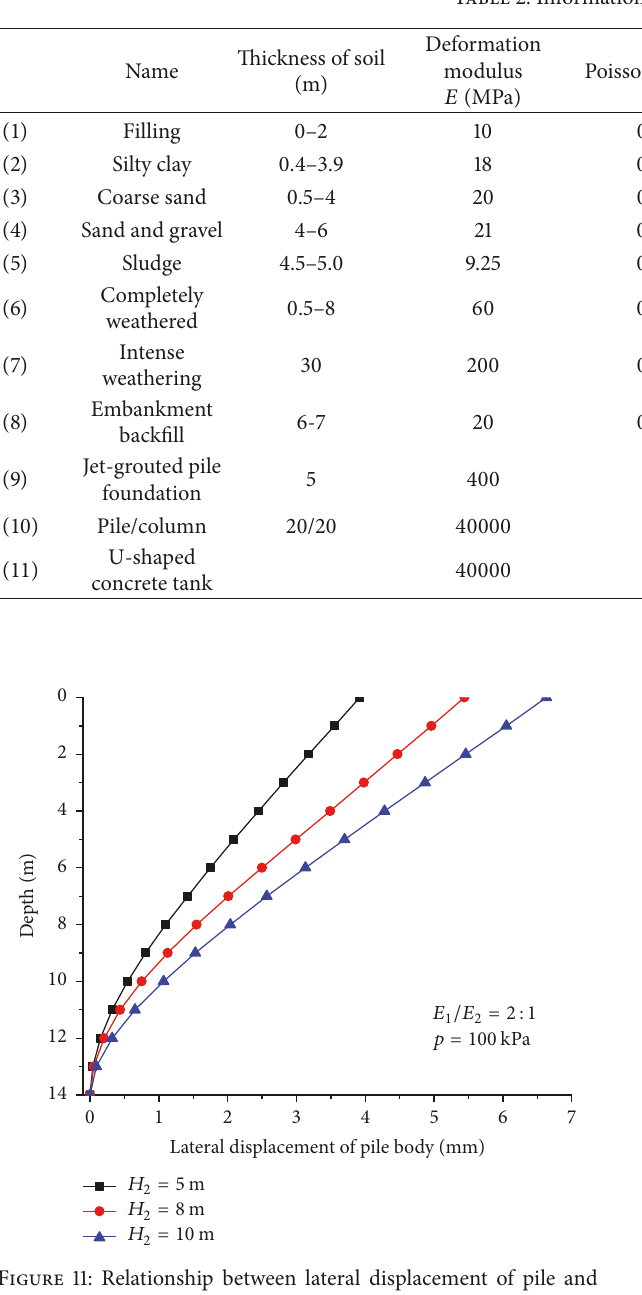
Table 2: Information of soil and pile.